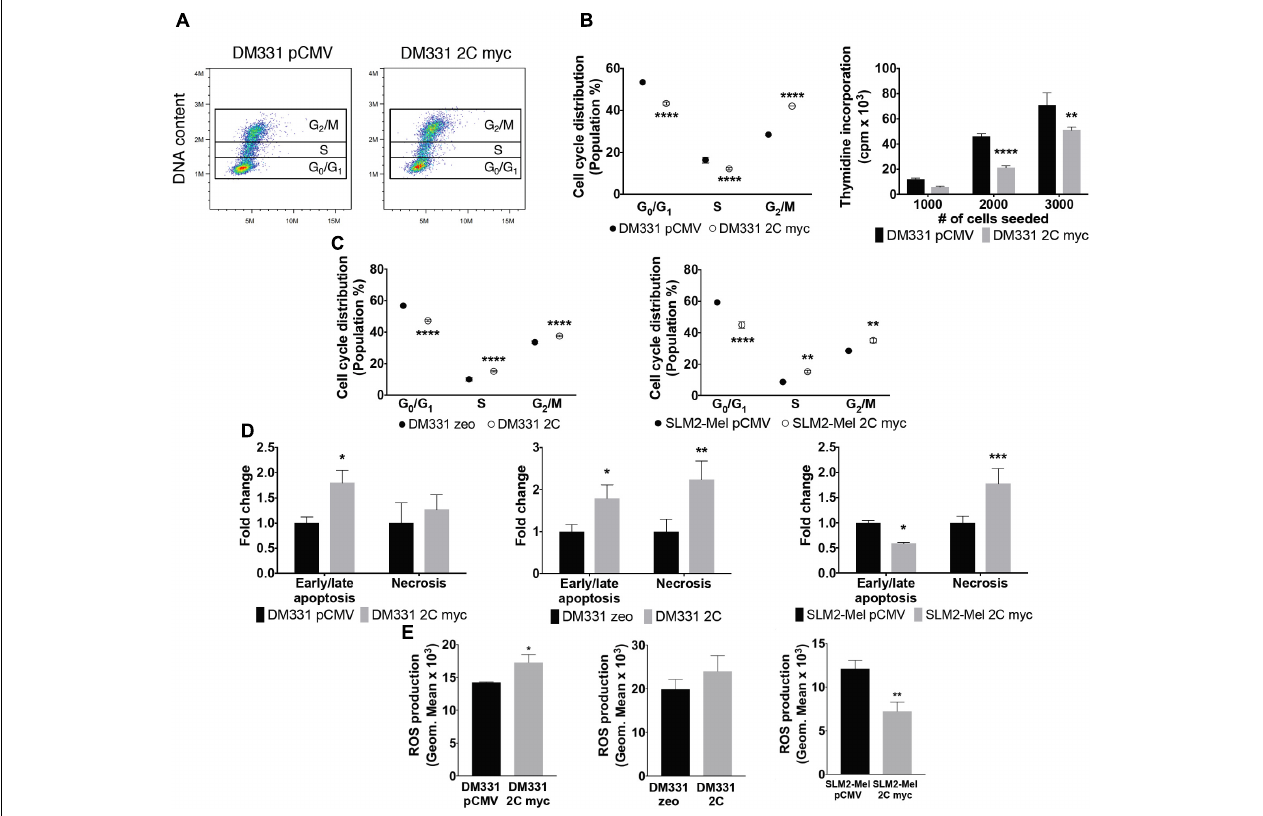
FIGURE 7 | Reduced survival and altered cell cycle in melanomas expressing LAMP-2C. (A) Apoptosis and necrosis were examined by incubating DM331 pCMV and DM331 2C myc cells with a fluorogenic substrate specific for activated caspase-3 and caspase-7 in apoptotic cells and AAD dead cell stain to detect necrotic cells. Apoptotic and necrotic cells were detected by flow cytometry. (B) Representative dot plot graph of the cell cycle distribution of DM331 pCMV and DM331 2C myc cells. Cell cycle distribution was evaluated by staining DNA content of DM331 pCMV and DM331 2C myc cells with propidium iodide and quantified by flow cytometry. (C) Cell cycle distribution of DM331 zeo and DM331 2C was evaluated by staining DNA content with propidium iodide and quantified by flow cytometry. (D) Cell cycle distribution was analyzed by staining the DNA content of SLM2-Mel pCMV and SLM2-Mel 2C myc with propidium iodide and detected by flow cytometry. (E) To examine basal ROS production, melanomas with and without ectopic LAMP-2C expression were incubated for 30 min at 37 ◦ C with 5 µ M CellROX Deep Red Reagent and monitored by flow cytometry. Data were analyzed by two-way ANOVA or by two-tailed, unpaired Student’s t -test. ∗ p < 0.05, ∗∗ p < 0.01, ∗∗∗ p < 0.001, and ∗∗∗∗ p < 0.0001 ( n =